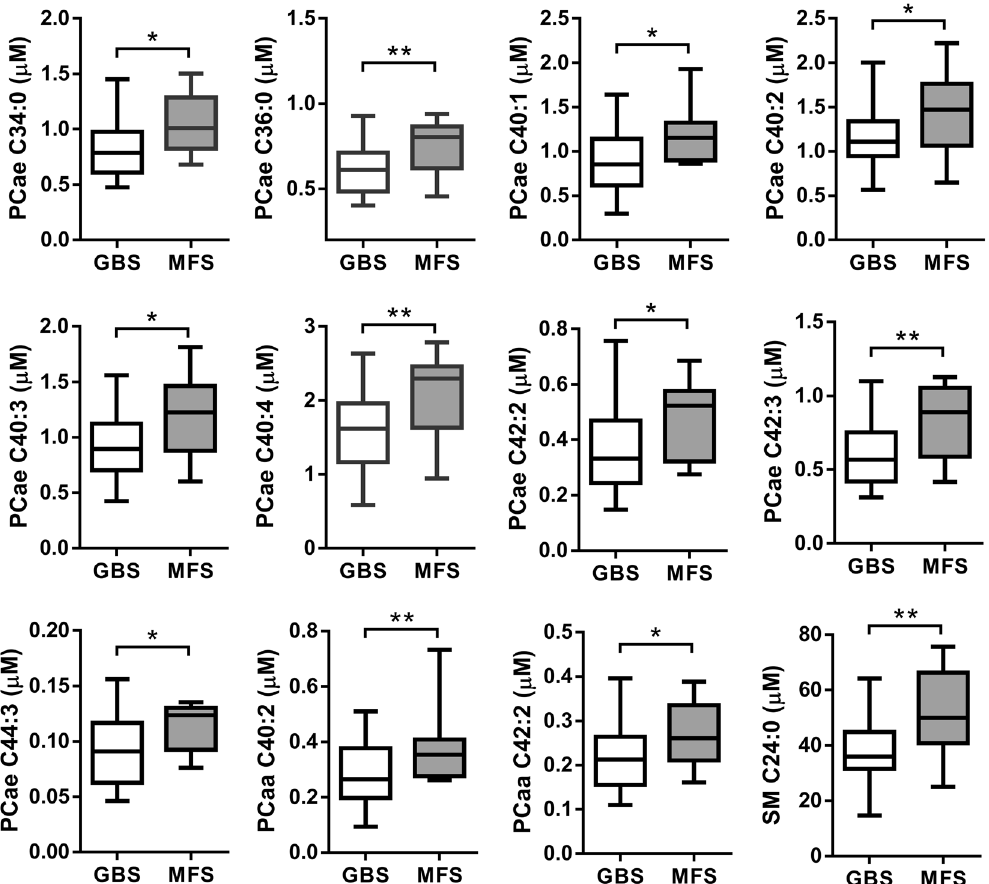
Figure 2. Metabolites were significantly decreased in GBS patients (n = 38) compared to Miller Fisher syndrome (MFS) (n = 10) patients. Statistical differences were determined by Student t-test; * p < 0.05, ** p < 0.01.